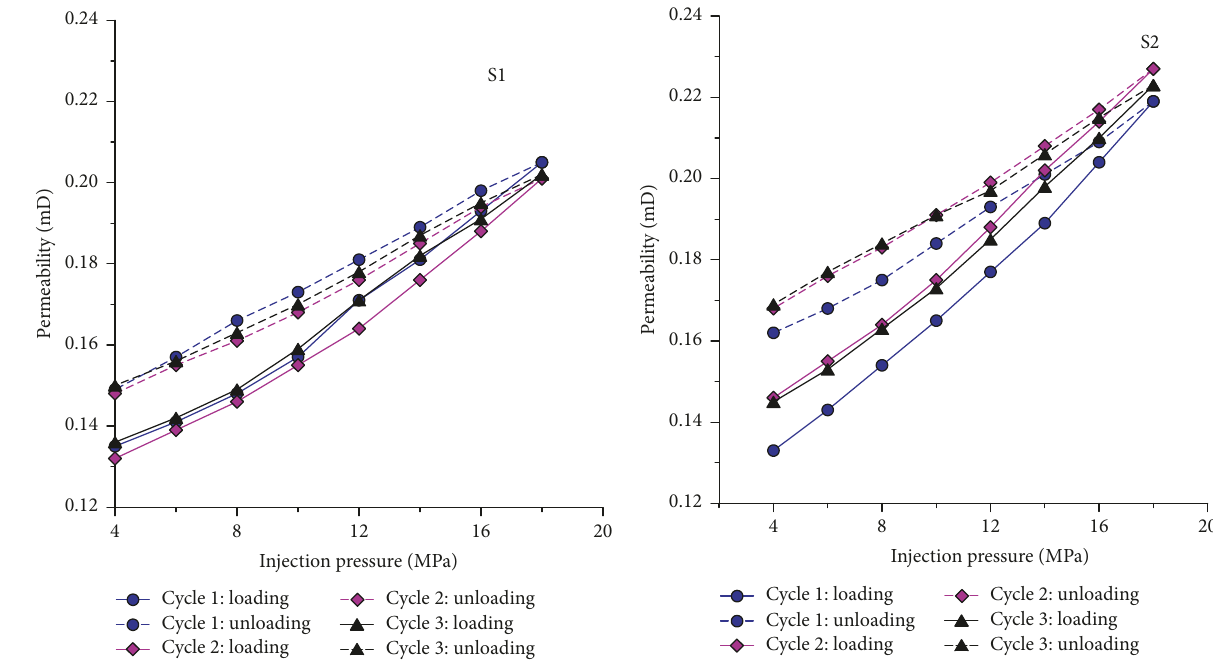
Figure 3: Relationship between permeability and injection pressure under constant confining